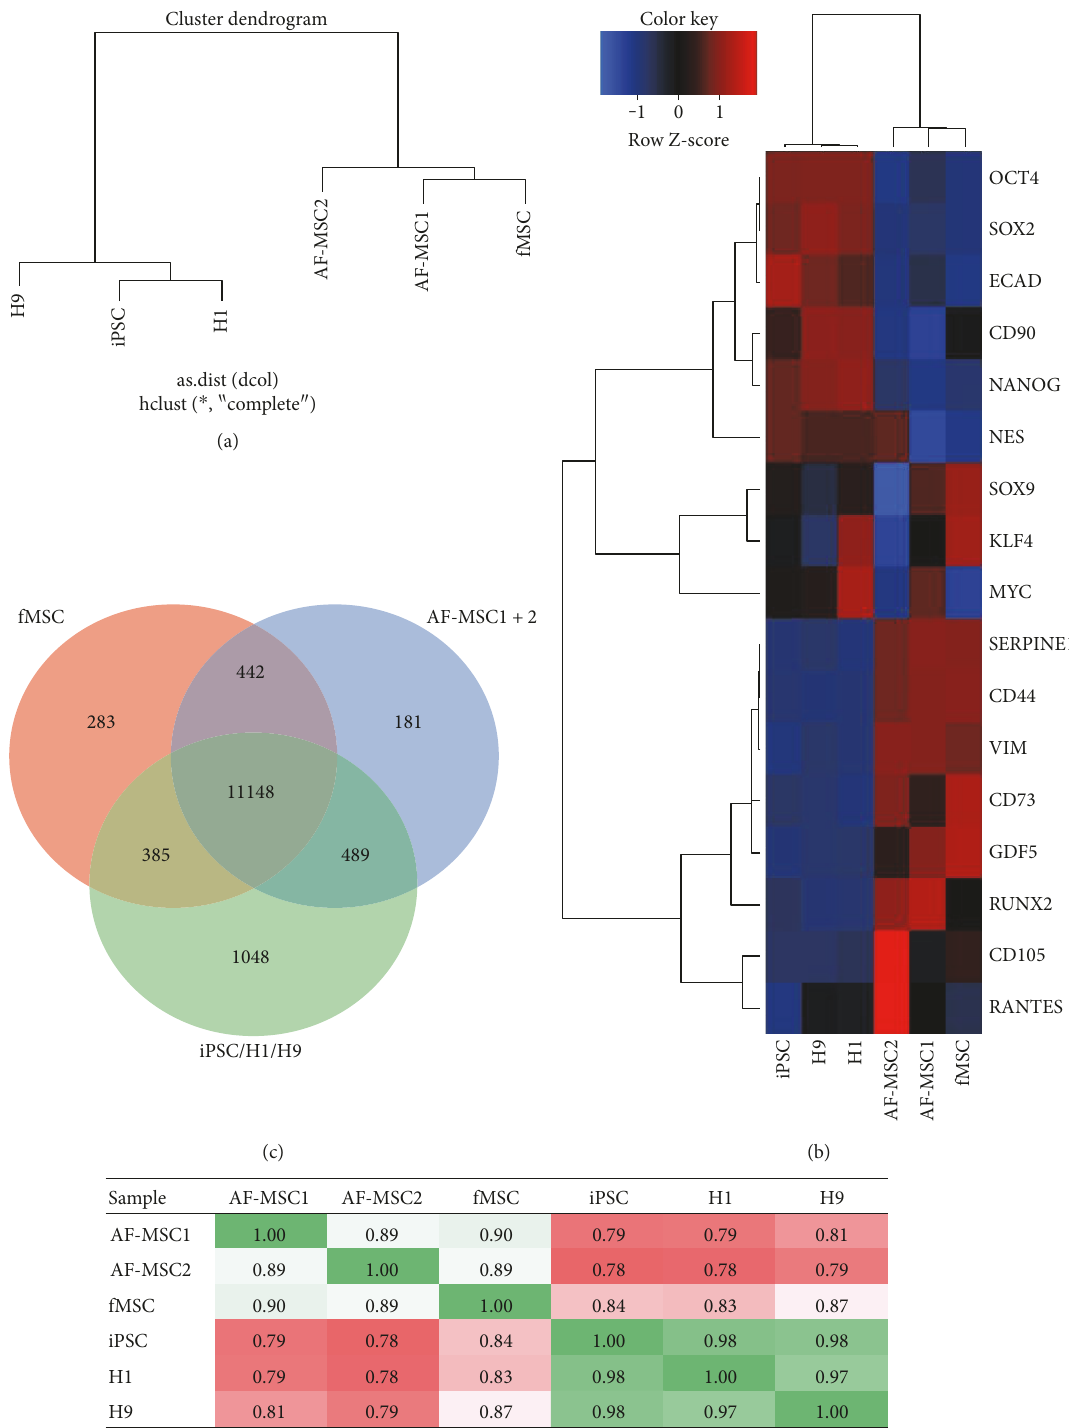
Figure 5: Overlapping and distinct gene expression in AF-MSCs. Dendrogram resulting from hierarchical clustering (a) of global gene expression pro fi les of AF-MSCs, fMSCs, and established pluripotent stem cells (H1, H9, and iPSCs). Transcriptomes of AF-MSC1 and AF-MSC2 cluster with fMSC while those of the H1, H9, and iPSCs cluster separately. The heatmap of 17 commonly up- or downregulated genes (b) shows similar gene expression of AF-MSCs and fMSCs. Venn diagram analysis revealed shared gene expression between fMSC, AF-MSCs, and pluripotent stem cells (c). Pearson ’ s correlation coe ffi cient was calculated based on the transcription data (d). Each replicate was pairwise compared with each other replicate. A value of 1 indicates perfect linear correlation while a value of 0 implies no correlation. Pearson correlation analysis of transcriptome data revealed a high correlation (green) of both AF-MSC1 and AF-MSC2 with fMSCs but low correlation (red) with pluripotent